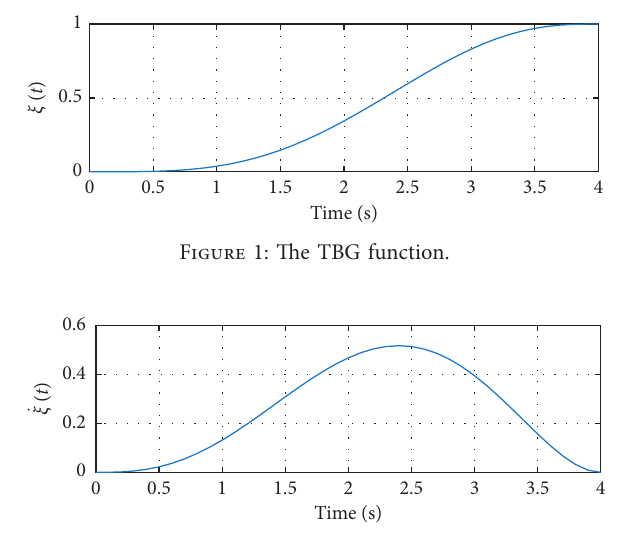
Figure 2: The derivative of the TBG